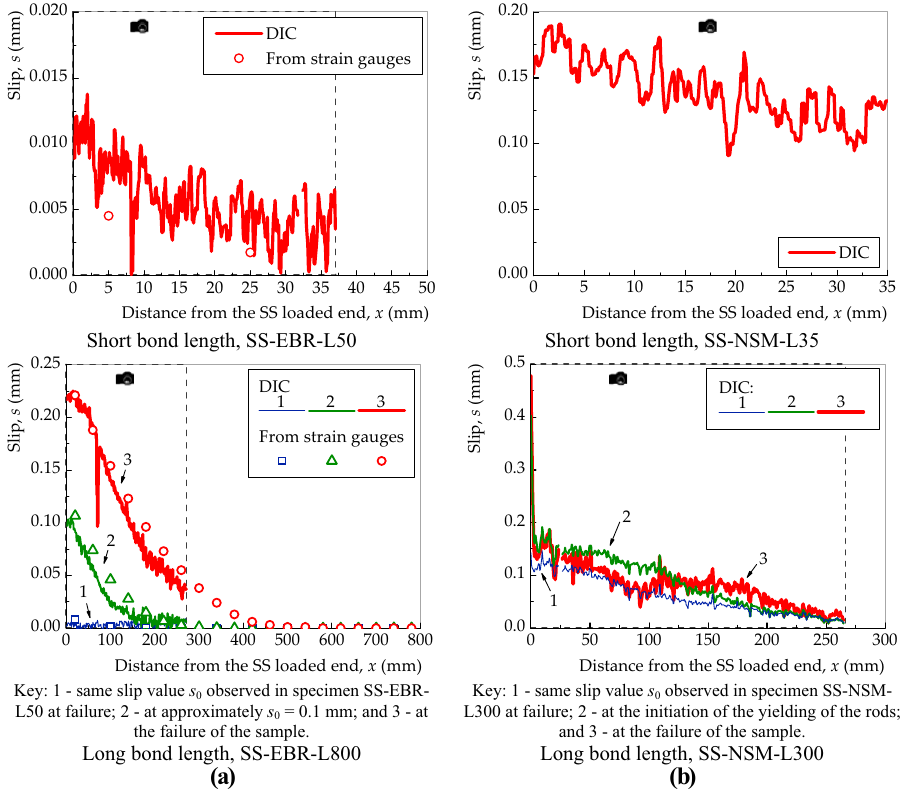
Fig. 10 Examples of the relative displacements obtained from the: a EBR samples; and b NSM